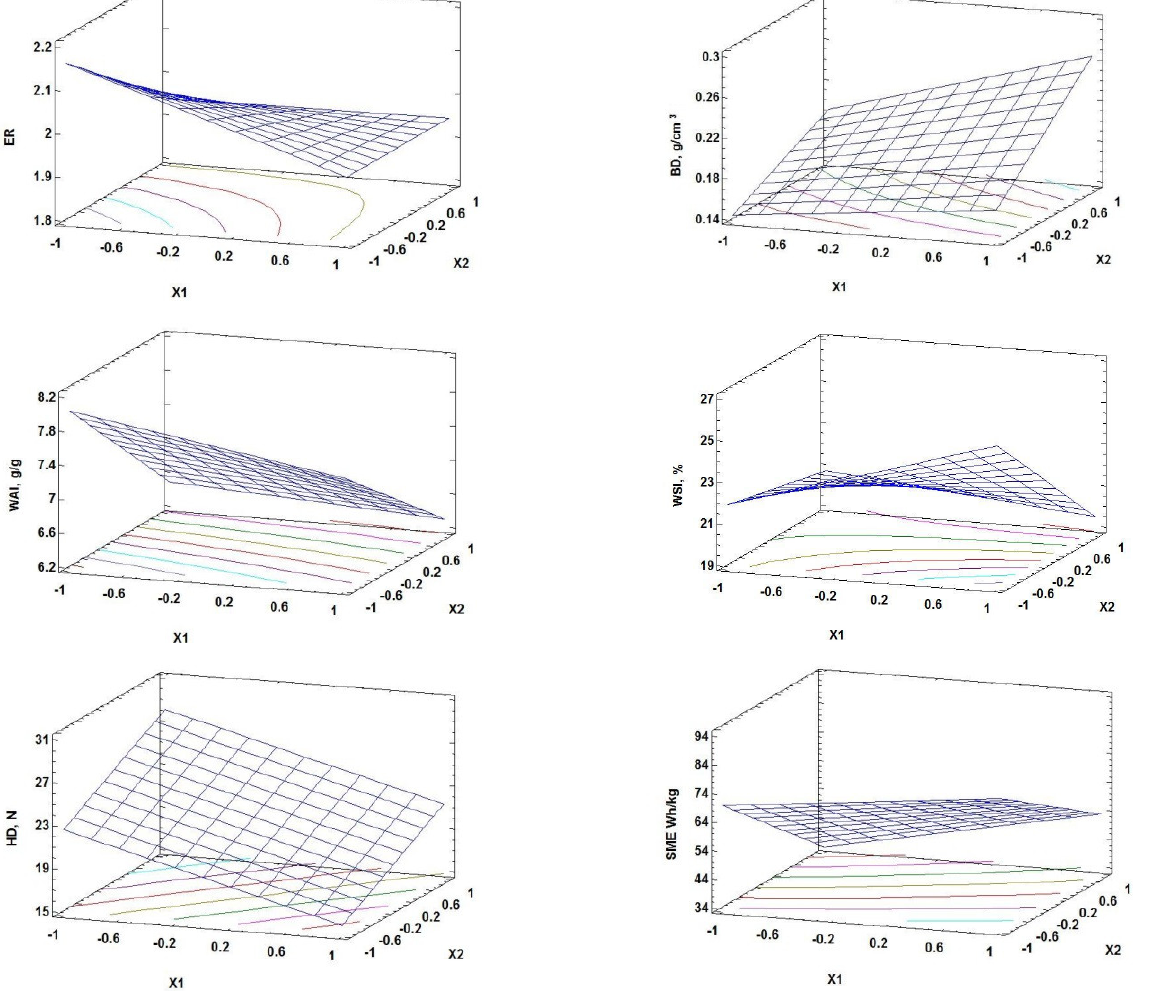
Figure 2. Response surfaces for the physical and functional characteristics ( X 1 : amount of goji berry; X 2 : feed moisture content). X 2 : feed moisture